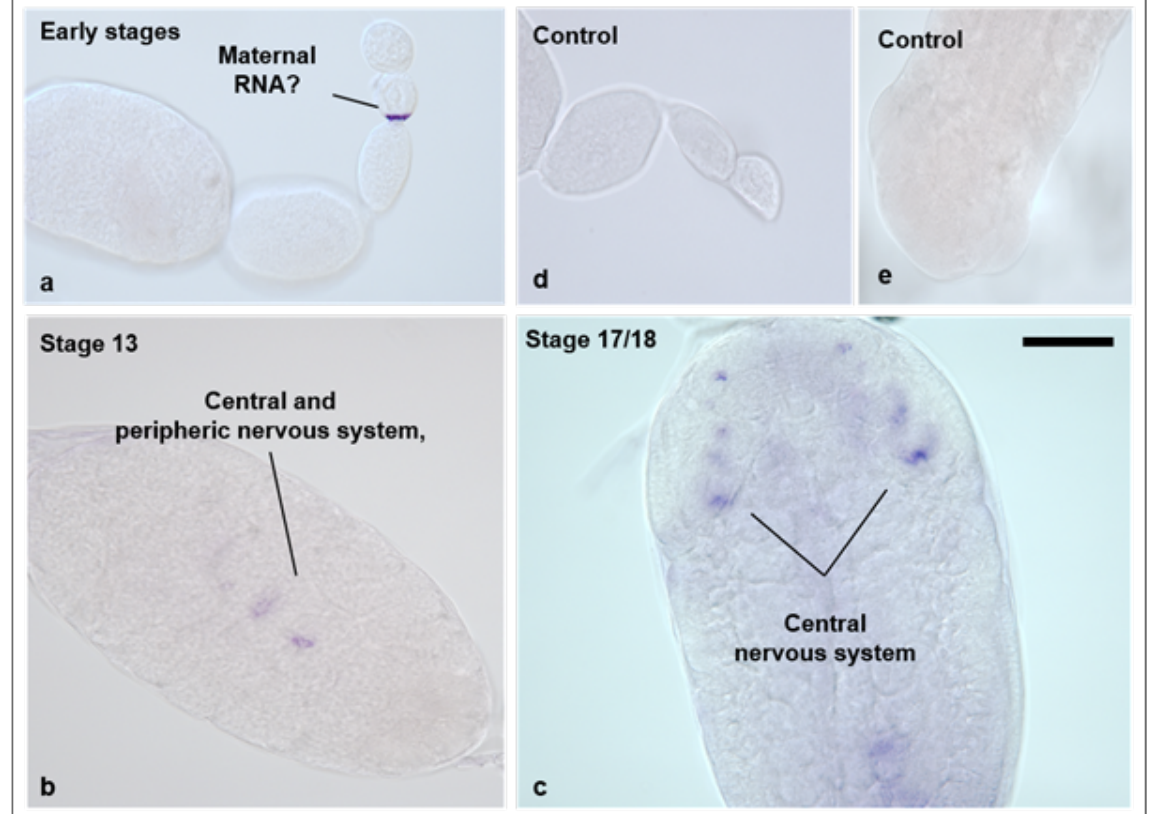
Figure 4 – In situ hybridization of pale transcripts within virginoparae embryos. Ovaries were dissected from virginoparae morphs and hybridized with antisense (a, b and c) or sense (d and e)